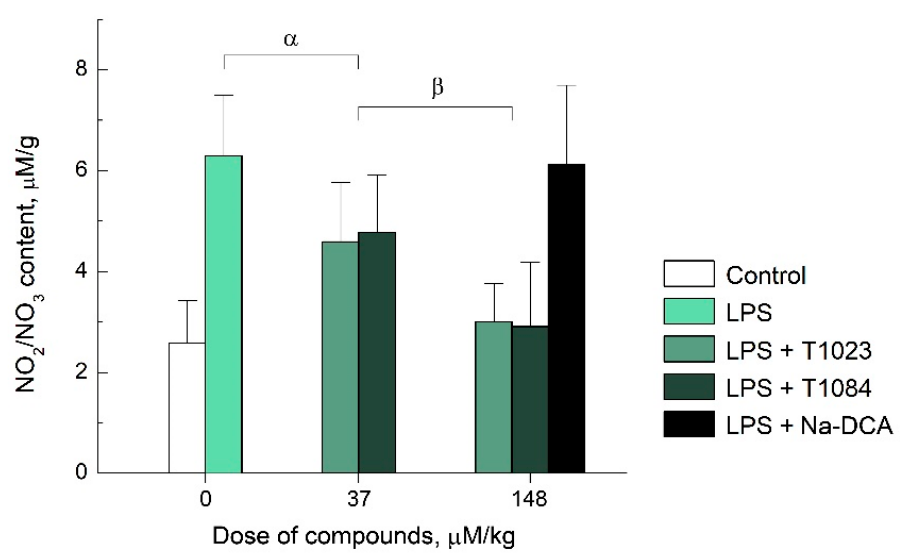
Figure 2. Effect of T1023 and T1084 with a single i.p. administration at equimolar doses of 37 µ M/kg (10.0 and 11.8 mg/kg, respectively); and T1023, Na-DCA, T1084 at equimolar doses of 148 µ M/kg (40.0, 22.2 and 47.1 mg/kg, respectively) on LPS-induced production of NO 2 /NO 3 in liver tissue of male mice F 1 (CBA × C57Bl/6j) (see Materials and Methods). Graphical deviations correspond to SD ( n = 24–27 per point). Significant intergroup differences are marked with α and β . α —between the group receiving only LPS and the groups receiving T1023 and T1084 at a dose of 37 µ M/kg (T1023: p = 0.00673; T1084: p = 0.00914, respectively); β —between the groups receiving NOS inhibitors at a dose of 37 and 148 µ M/kg (T1023: p = 0.00257; T1084: p = 0.01846, respectively).